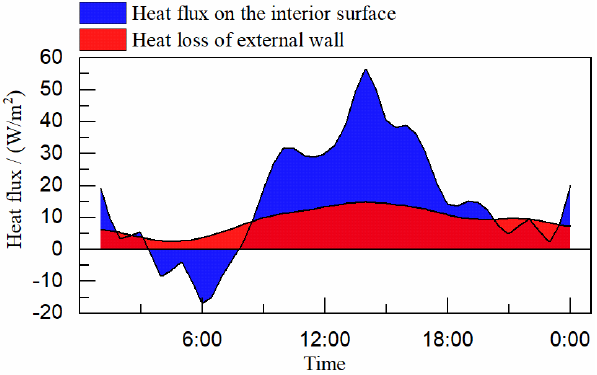
Figure 20. Heat flux on the interior surface and heat loss of external wall.